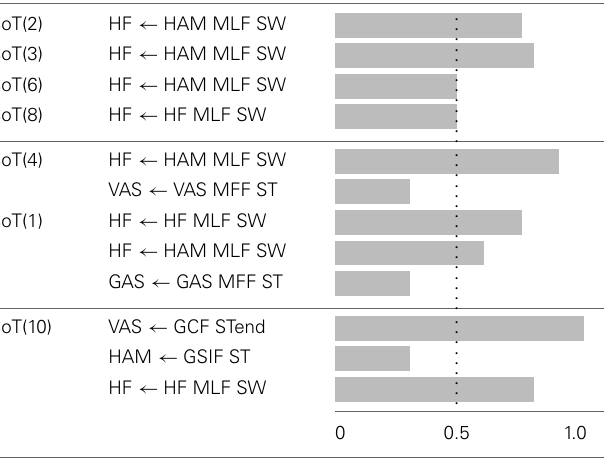
Table 4 | Feedback sensitivity (see section 2.5.3) for the best 7 solutions (in terms of IN sen replacement capacity, i.e., percentage of IN sen that can not be replaced by a CPG-OSC